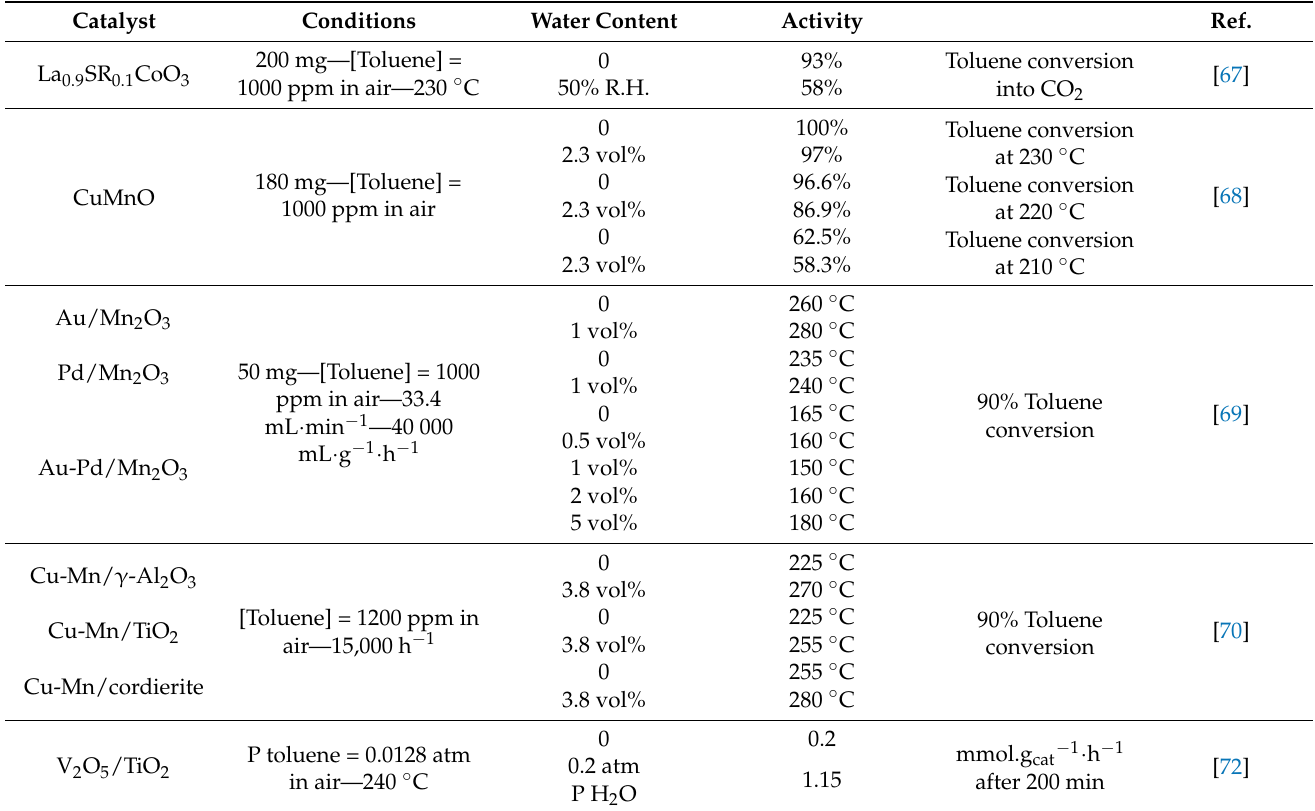
Table 4. Summary of moisture effect over toluene